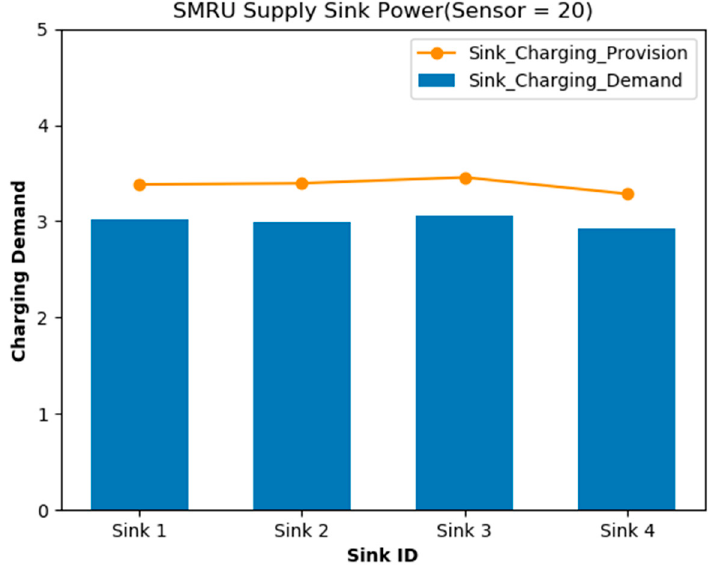
Figure 13. The energy consumption and supplementary of sink nodes with different sink rates.